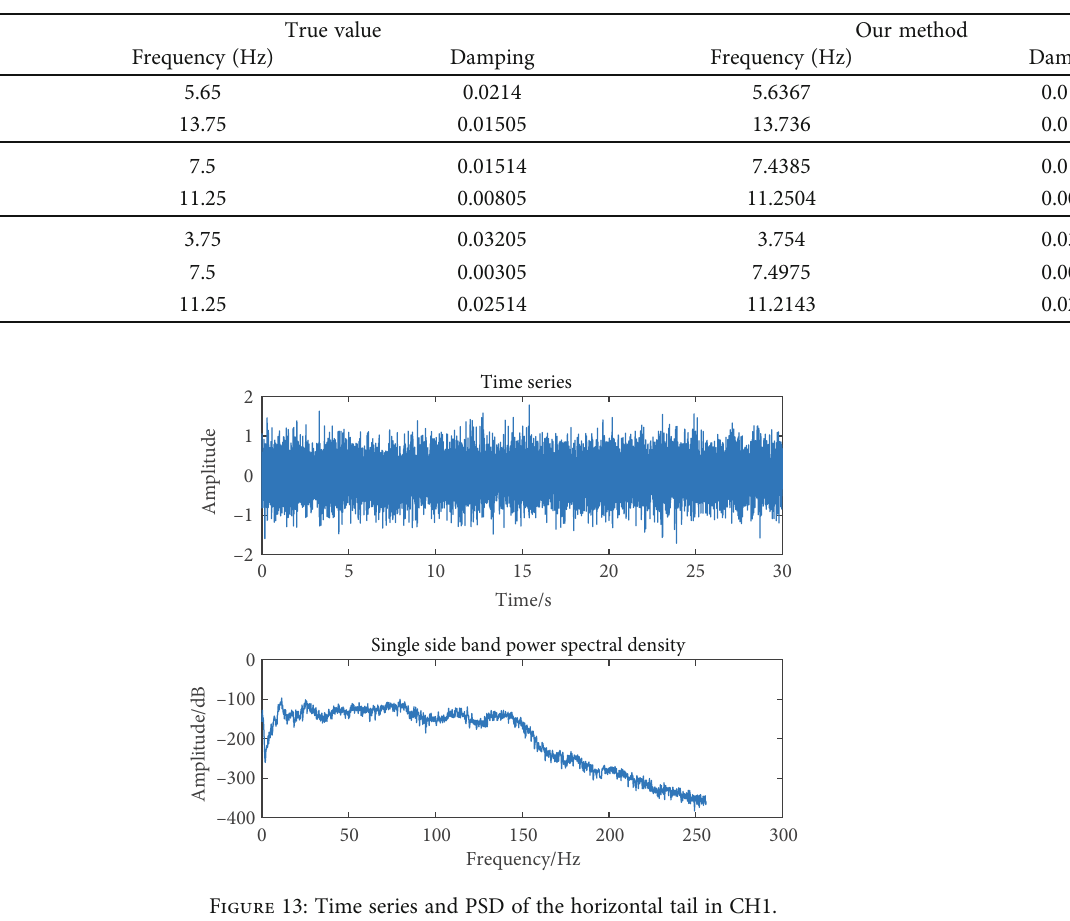
Figure 12: System identi fi cation Table 2: Model parameter identi fi cation results of the simulation signal.